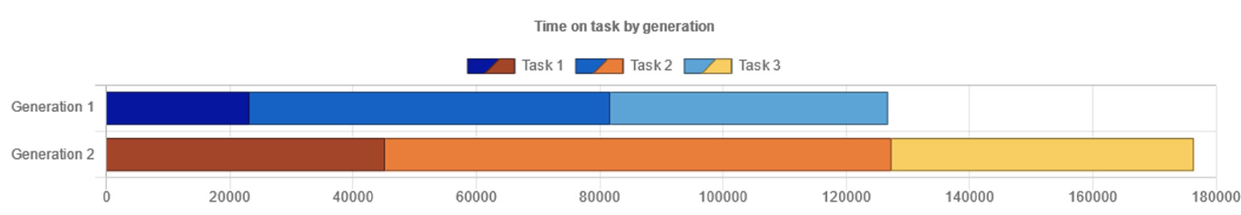
Figure 13. Time on task by generation in milliseconds.